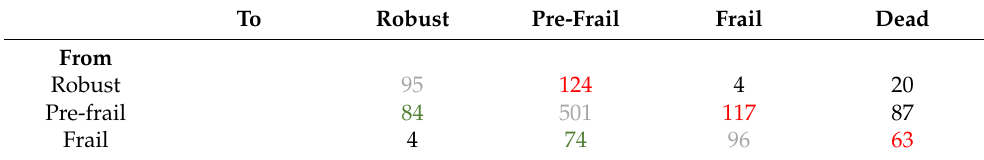
Table 2. Number of “transitions” between each frailty state and to death over four years. To Robust Pre-Frail Frail Dead From Robust 95 124 4 20 Pre-frail 84 501 117 87 Frail 4 74 96